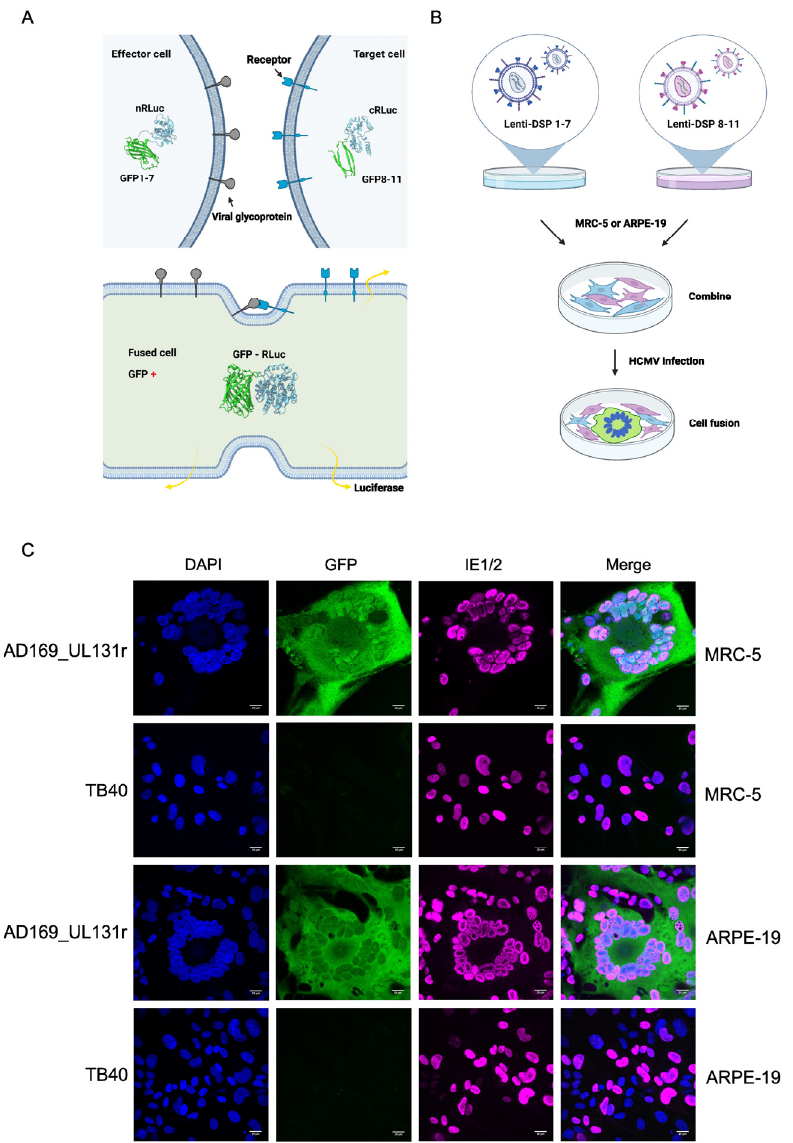
Figure 3. Adaptation of the RLuc-GFP dual split protein (DSP) reporter system to detect HCMV- induced cell–cell fusion. ( A ) Fusion of cells expressing DSP 1–7 and DSP 8–11, respectively, leads to complementation of the split GFP and RLuc proteins. ( B ) Generation of DSP-expressing MRC-5 and ARPE-19 cells by lentiviral transduction. ( C ) Visualization of syncytia using the DSP system. Syncytia containing the complete RLuc-GFP are green fluorescent. The IE1 and IE2 proteins were detected by indirect immunofluorescence, and nuclei were stained with DAPI. Scale bar, 20 μ m.